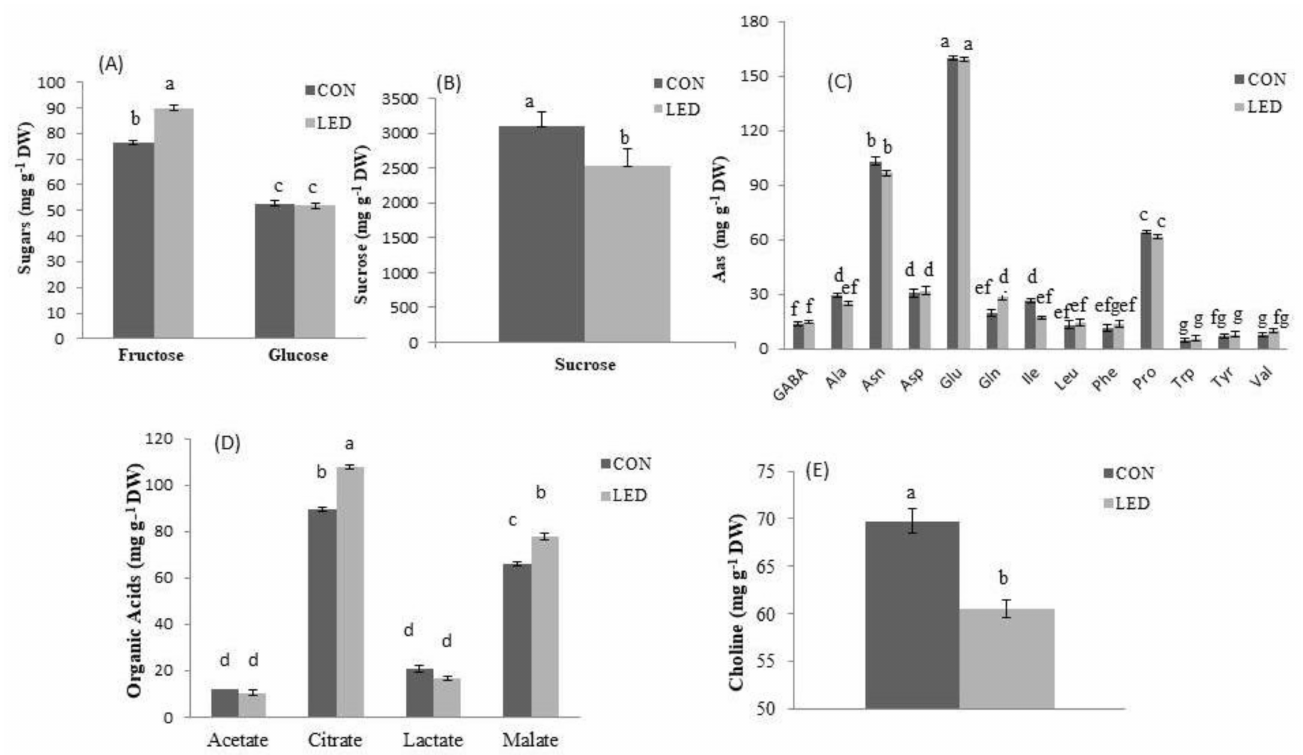
Figure 5. Concentrations (mg g − 1 DW) of ( A ) sugars, ( B ) sucrose, ( C ) amino acids (Aas), ( D ) organic acids, and ( E ) choline in Control (CON, unlighted) pepper seeds and in seeds previously irradiated with a pulse of R LED light (LED) after radicle emergence during germination (at 96 h of imbibition). Bars are means ± SE ( n = 5). Different letters denote a statistically significant difference ( p < 0.05, Tukey’s test) between